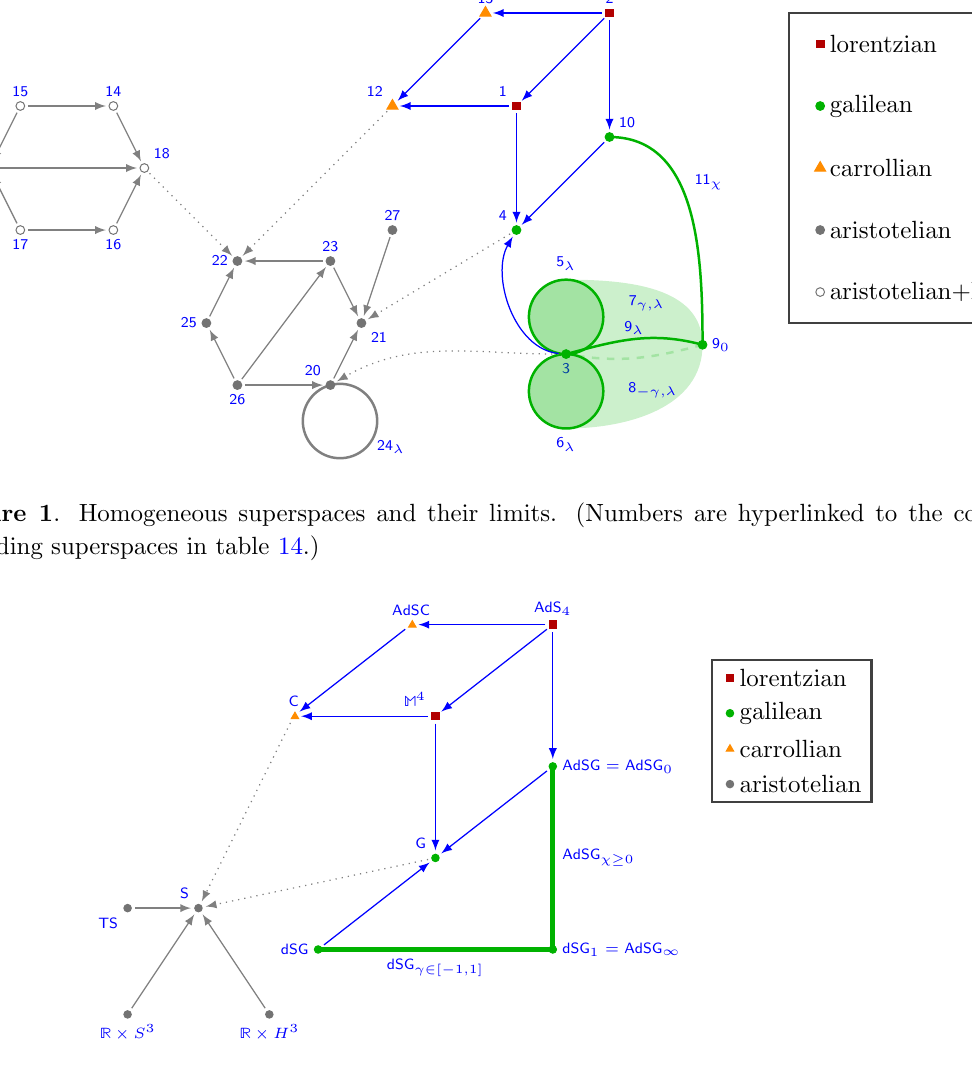
Figure 2 . Limits between superisable